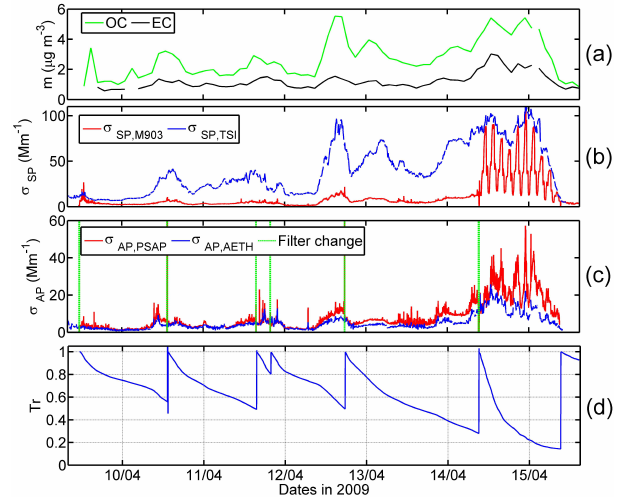
Fig. 3. The values in the figure are (a) organic carbon (OC), elemen- tal carbon (EC), (b) σ SP , M903 (heated) at 545nm, σ SP , TSI (cool) at 550nm, (c) σ AP , PSAP (heated) at 545nm, σ AP , AETH (cool) at 880nm, and (d) PSAP filter transmittance (Tr)